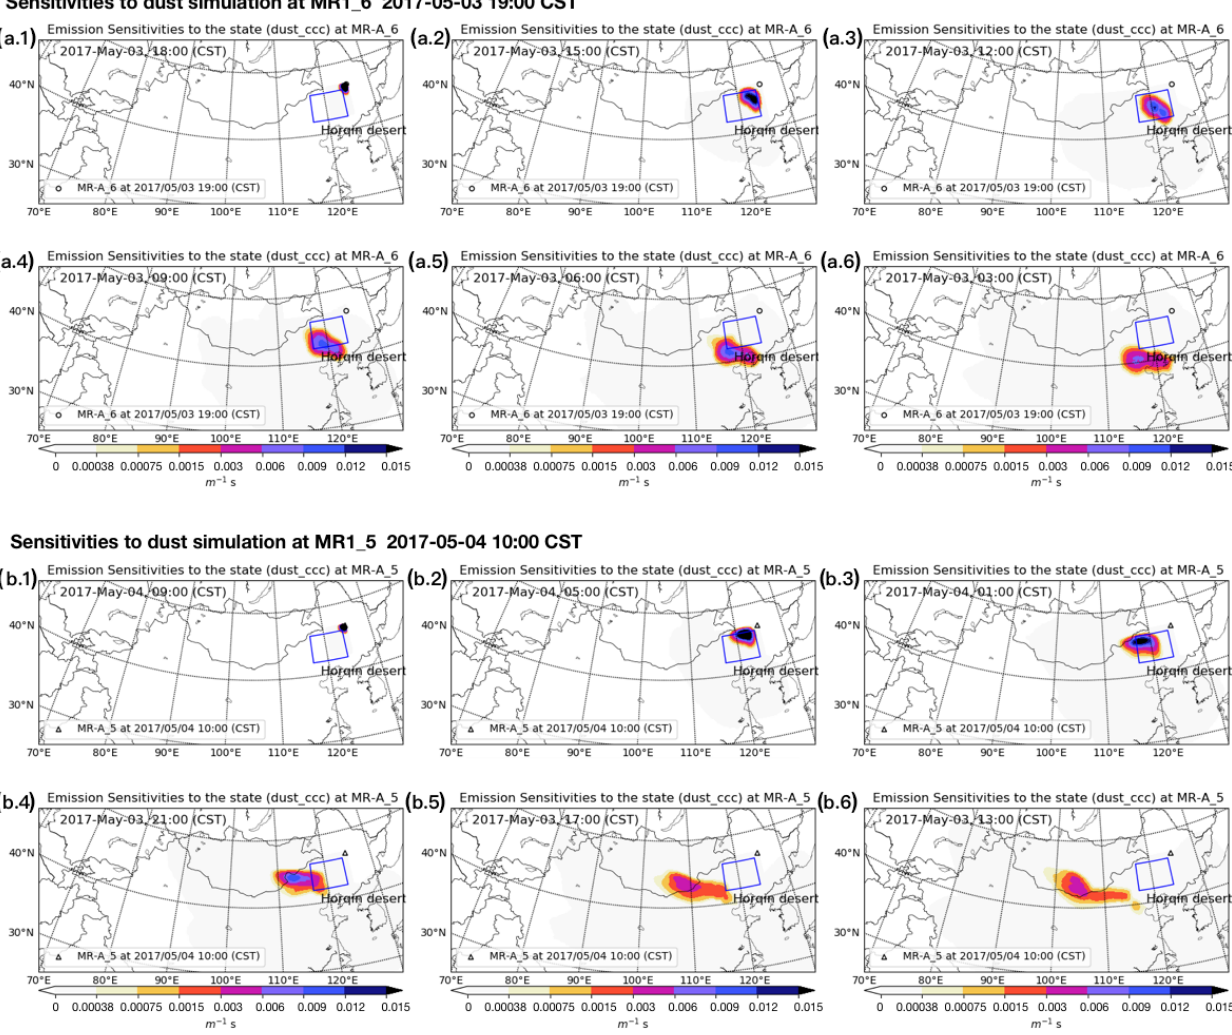
Figure 8. Backward time series of emission sensitivity of the dust simulation at MR-A_6 3 May 2017, 19:00CST: emission sensitivity distribution on 3 May 2017, 18:00 (a.1) , 15:00 (a.2) , 12:00 (a.3) , 09:00 (a.4) , 06:00 (a.5) , 03:00 (a.6) ; and of the dust simulation at MR-A_5 4 May 2017, 10:00: emission sensitivity distribution on 4 May 2017, 09:00 (b.1) , 05:00 (b.2) , 01:00 (b.3) , 3 May, 21:00 (b.4) , 17:00 (b.5) , 13:00 (b.6)